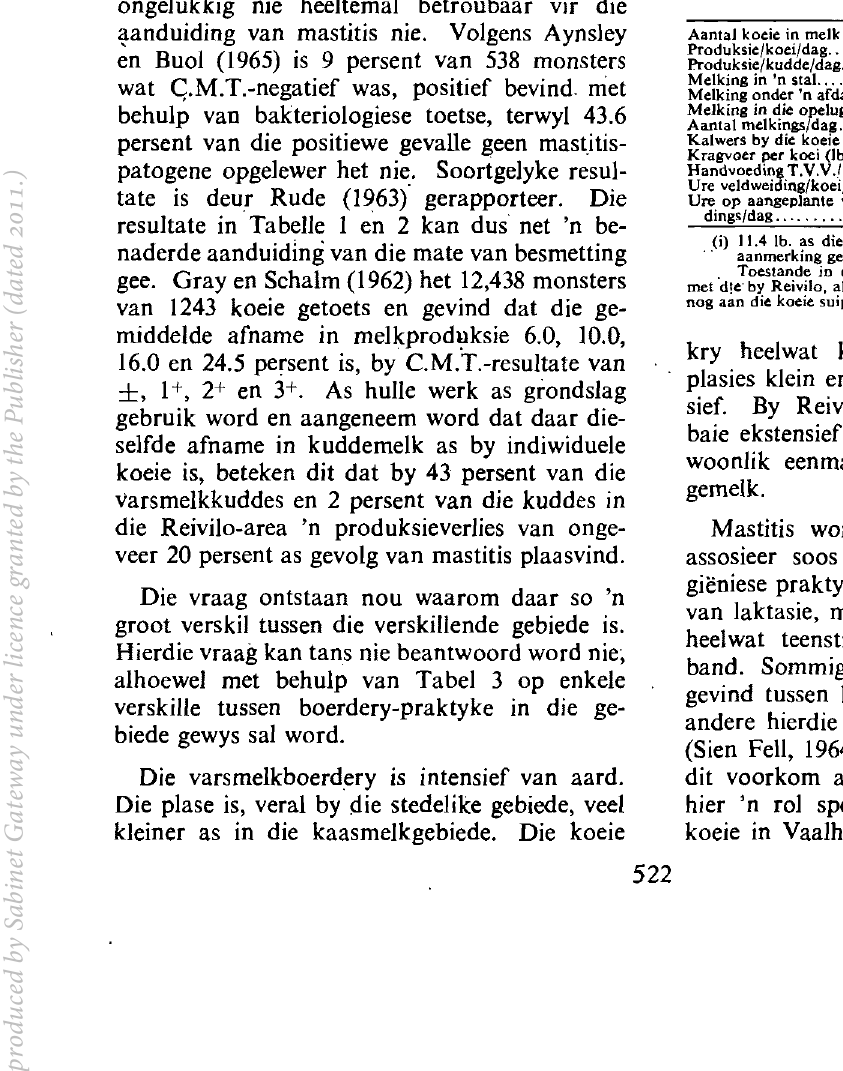
TABEL 3. VERSKILLE IN MELKBOERDERYPRAKTYKE TUS- . SEN VARSMELK- EN KAASMELKPLASE Varsmelk , Vaalharts Reivilo (Sentraal-